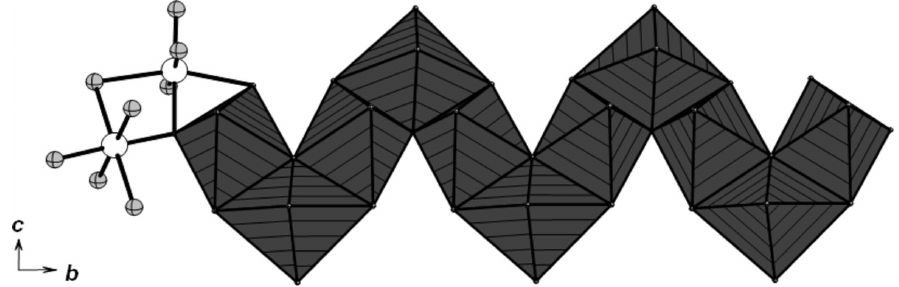
Figure 2 Chains of edge-sharing CuO